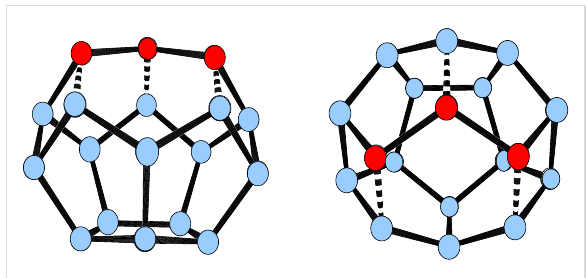
Figure 7: A possible route to undecahedrane 15 (left: side view; right: top view).